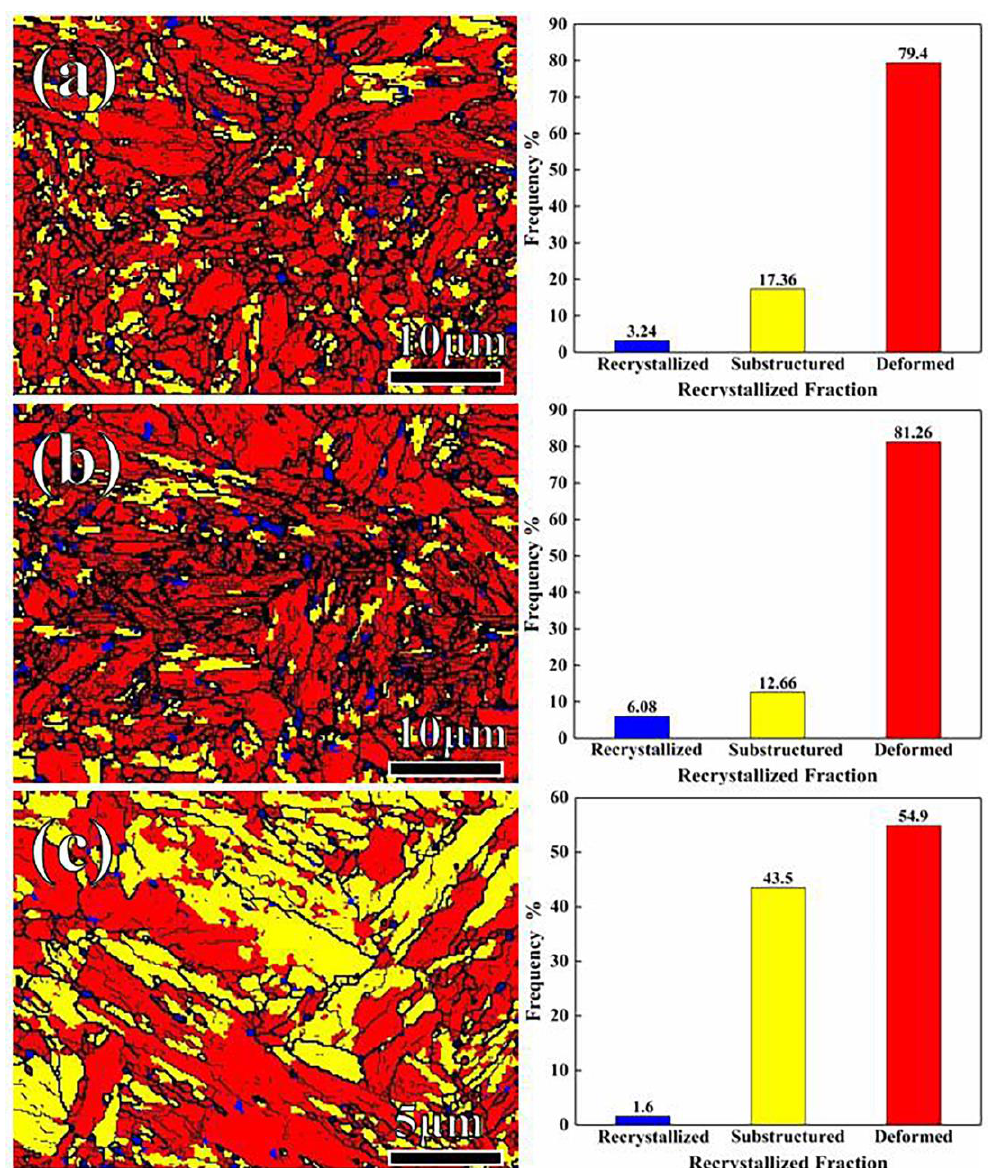
Figure 10. Recrystallization analysis: ( a ) P300 specimen; ( b ) P260 specimen; ( c ) P240